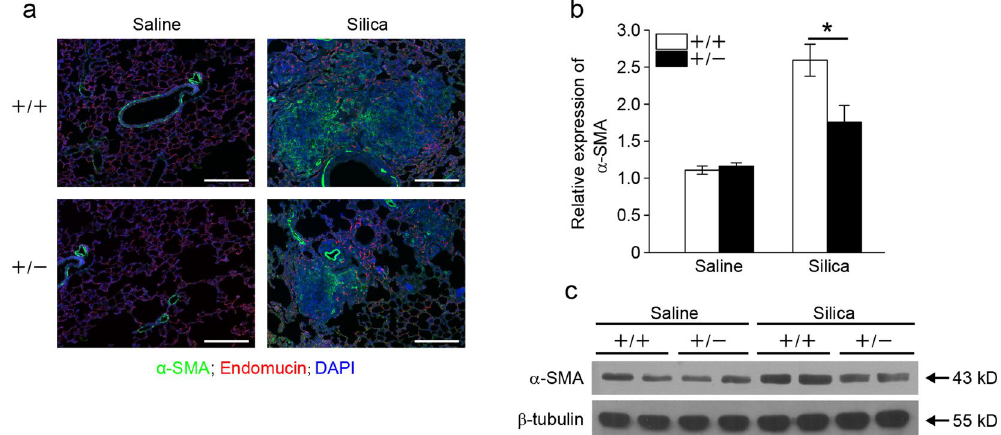
Figure 4. Fstl1 + / − mice have less myofibroblast accumulation after silica exposure. ( a ) Immunofluorescence analysis of α -SMA expression in lung sections of Fstl1 + / − and WT mice 21 days after saline or silica exposure. Representative images of the staining are shown. ( α -SMA, green; Endomucin, red; nucleus, blue; scale bars, 200 μ m). ( b ) qRT-PCR analysis of α -SMA mRNA expression in lung tissues from Fstl1 + / − and WT mice 21 days after saline or silica treatment (n = 3 per group; * P < 0.05 by one-way ANOVA followed by Student’s t test). ( c ) Western blot analysis of α -SMA expression in lung tissues from Fstl1 + / − and WT mice 21 days after saline or silica treatment. β -tubulin was used as a loading control.